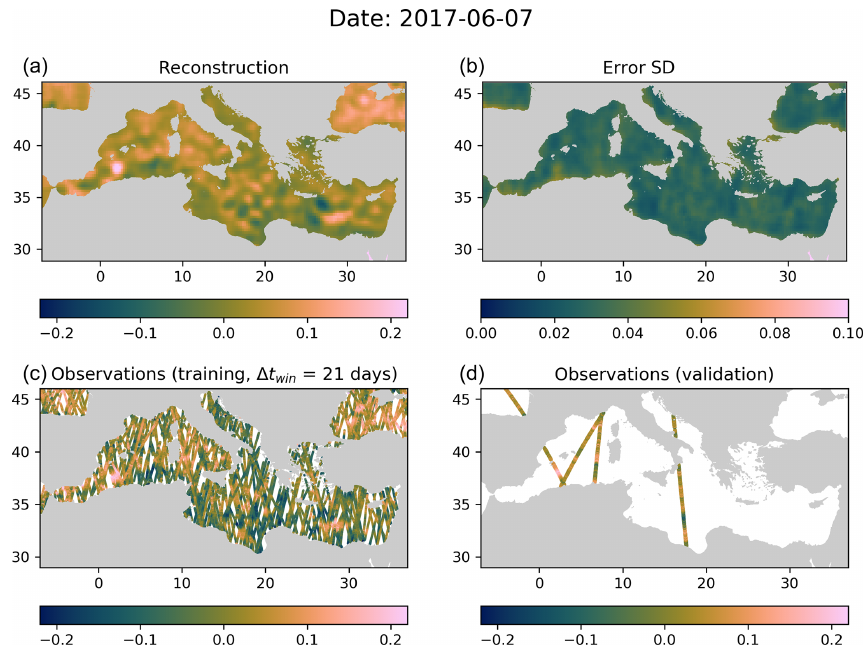
Figure 8. Panel (a) Reconstructed SLA by DINCAE, (b) expected error standard deviation by DINCAE, (c) data used during training (partial) and (d) independent data for validation withheld during analysis. All panel values are in